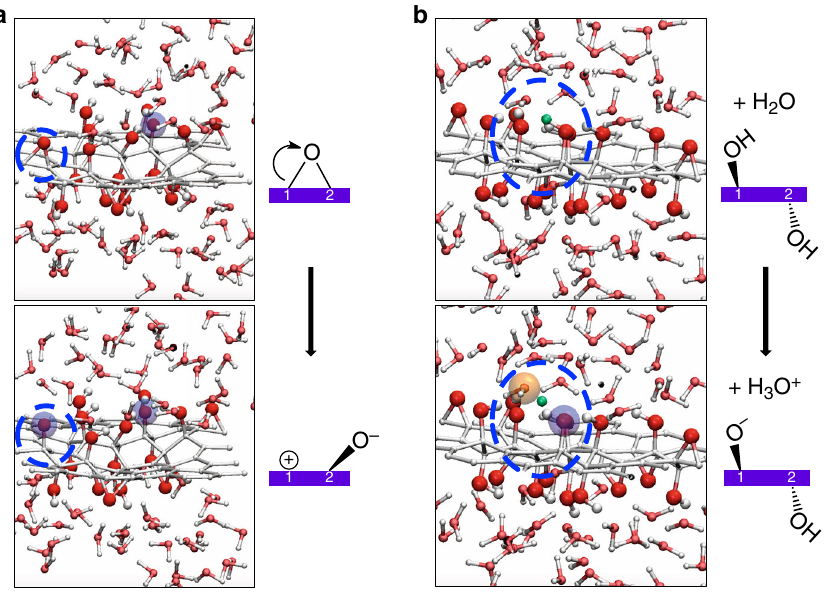
Fig. 3 Snapshots taken from molecular dynamics simulations. These snapshots are taken from trajectories of semiordered graphene oxide models in liquid water. a Opening of an epoxide function, leading to a zwitterionic form of the graphene oxide, but creating no net charge of the GO sheet. b Deprotonation of a surface hydroxyl group, leading to a surface alcoholate (blue shaded circles) and an excess proton (orange) in the liquid water. The labile hydrogen atom is highlighted in green. Schematics are presented on the right side, for